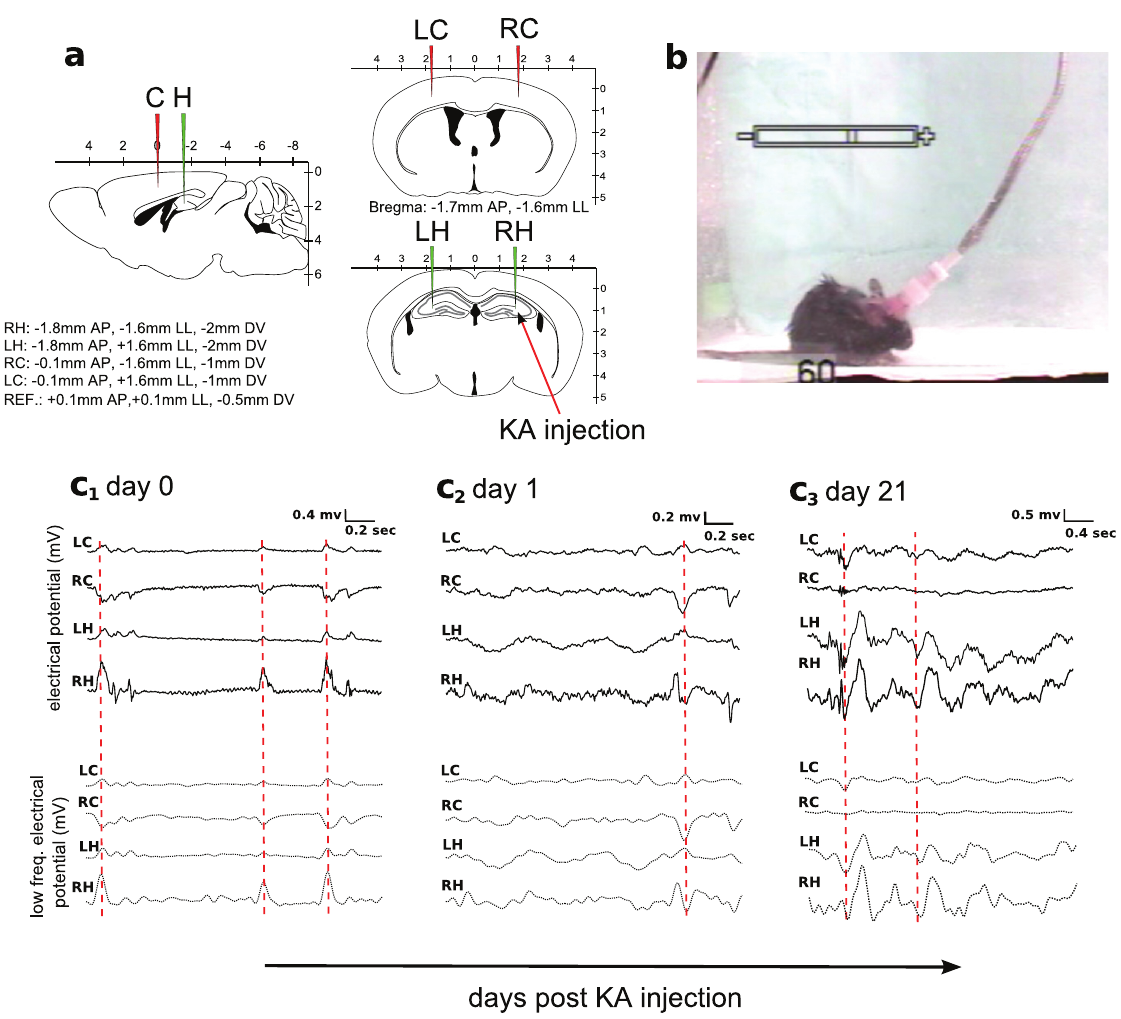
Figure 1. Intracranial EEG recordings from MTLE mice. a : Experimental setup. The intracranial placement of site recordings consisted on two electrodes placed bilaterally in the cortex (LC and RC, red) and two in the hippocampus (LH and RH, green). b : EEG recording was coupled to videographic recordings for visual confirmation of the seizure events. c1 - c3 : Examples extracted from the EEG recordings at the day of the injection ( c1 ), the next day ( c2 ) and after 21 days ( c3 ). Overall changes in the electrical potential are shown in the upper row and after filtering for low frequency (1–14 Hz) in the lower row. The red dotted line marks high statistical similarities between electrodes, what provides high values of FC. Notice that RH is the site of the KA injection, and shows a higher epileptogenic activity that can be easily detected by looking at the amplitude of the time series associated to the RH